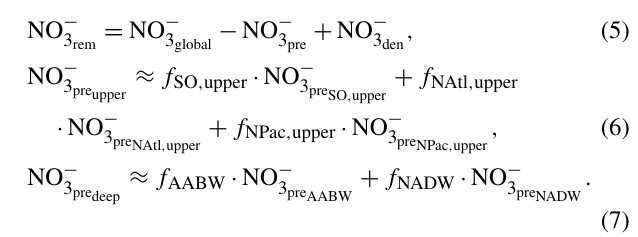
Figure 9. Iron-fertilized changes in total global average DIC and each of the components (iron fertilization simulation minus associ- ated control run). Simulations were either run under pre-industrial or glacial-like conditions (in the case of the latter, results represent the average of the four GL runs, with error bars showing the stan- dard deviation within the four runs), as well as using 100 and 75% of the default remineralization rate of organic matter. The close agreement of panels (a) and (b) indicates that the effects of iron fertilization and changes in the remineralization rate are approxi- mately linearly additive in this